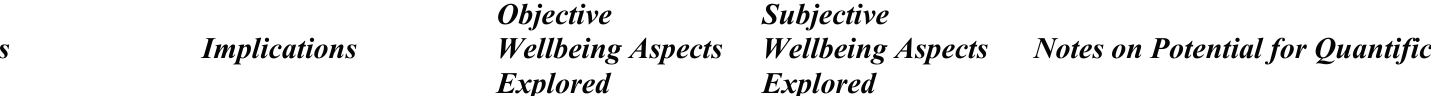
Table 2. Selected examples of wellbeing implications of urban GHG policy implications and potential for quantification of associations *